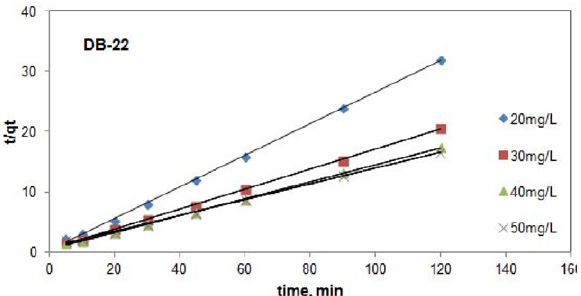
Fig. 14 Pseudo second order model for the adsorption of DB-22 onto